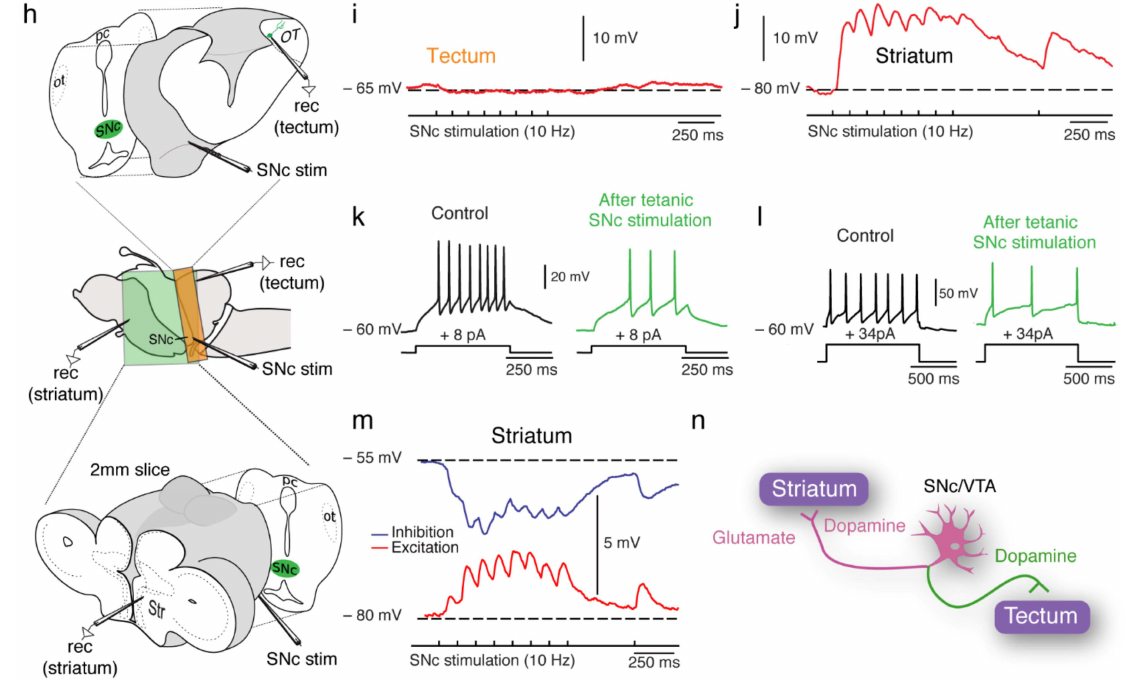
Figure 2. SNc/VTA connectivity in the lamprey is largely identical to that of mammals. Apart from projections to the striatum, the SNc/VTA directly projects to motor centers. ( a ) A schematic showing the overall connectivity of the lamprey SNc/VTA. The striatum, pallium (cortex homologue), lateral habenula, and pedunculopontine nucleus (PPN) provide inputs, as do different sensory regions. Among these sensory inputs, the tectum (homologue of the mammalian superior colliculus) provides salience information (shadowed in red). The lateral habenula provides direct inputs and regulates dopaminergic activity via indirect projections through the rostromedial tegmental nucleus (RMTg). This is the same evaluation circuit found in mammals (shadowed in green). Apart from the well-studied projection to the striatum, there are also direct projections to motor centers, both in lampreys and in other vertebrates, including mammals. DLR, diencephalic locomotor region; GPe, globus pallidus externa; MLR, mesencephalic locomotor region; SNc, substantia nigra pars compacta ; SNr, substantia nigra pars reticulata ; GPi, globus pallidus interna; STN, subthalamic nucleus; VTA, ventral tegmental area. Modified from [3]. ( b ) (right) Microphotography of the lamprey SNc/VTA dopaminergic population stained with an anti-TH antibody. Scale bar: 100 µ m. (left) Mapping of neurons in the SNc/VTA (delimited with a dotted line) expressing only dopamine (pink) and co-expressing dopamine and glutamate (orange). Scale bar: 200 µ m. The percentage of each type is shown in the graph in ( c ). ( d ) Graph showing the number for each of the neurotransmitter phenotypes exhibited by the neurons in the SNc/VTA that project to the tectum. TH is used as a marker for dopamine, and vGluT and GAD for glutamate and GABA, respectively. ( e ) Schematic drawing showing the injection site in the SNc/VTA that results in anterogradely labeled fibers in the striatum and tectum. ( f ) Anterogradely labeled fibers from injections in the SNc/VTA (green) express both TH (red) and vGluT (pink). Scale bar: 10 µ m. ( g ) On the contrary, fibers targeting the tectum (green) express TH (red), but no vGluT (pink). Scale bar: 25 µ m. ( h ) Experimental preparations used to record intracellularly in the tectum (OT; top) or striatum (str; bottom) in response to stimulation in the SNc/VTA. ( i ) No glutamatergic effects are evoked in tectum in response to SNc/VTA stimulation, whereas the same stimulation results in EPSPs in the striatum ( j ). ot, optic tract; pc, posterior commissure. ( k ) Tetanic stimulation of the SNc/VTA evokes dopaminergic effects in the tectum. A representative tectal neuron is shown that undergoes a reduction in excitability (therefore expressing the D 2 dopamine receptor). For the same stimulus pulse, the number of evoked action potentials is lowered after the tetanic stimulation (green), in comparison to the control stimulation (black), in which the SNc/VTA tetanic stimulation has not yet been performed. ( l ) The same experiments show that SNc/VTA stimulation results in excitability changes in striatal neurons. ( m ) In some cases, both glutamatergic (EPSPs) and inhibitory (IPSPs) effects are observed in striatal neurons after SNc/VTA stimulation. ( n ) A summarizing schematic. Dopaminergic neurons in the lamprey SNc/VTA simultaneously target the striatum and tectum and co-express dopamine and glutamate. Both neurotransmitters are released in the striatum, whereas in the tectum, only dopamine is released. Modified from